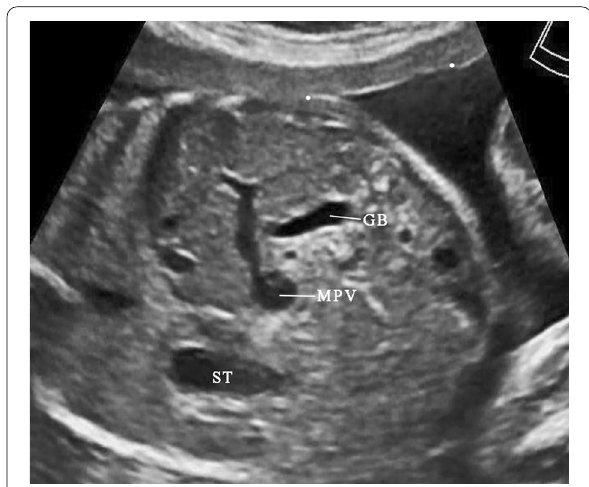
Fig. 5 Grayscale ultrasound images showing fetal portal vein aneurysm. In utero abdominal plane demonstrating focal dilatation of the